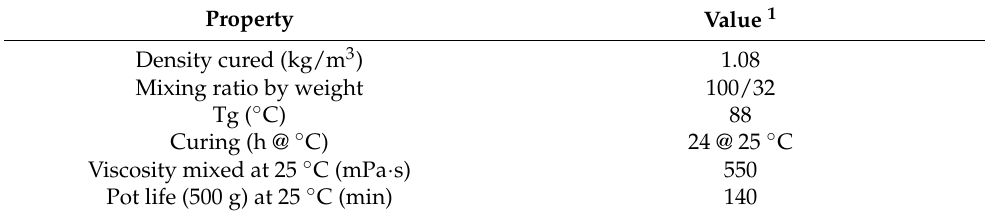
Table 1. Epoxy resin used in ZnO-epoxy composites. Property Value 1 Density cured (kg/m 3 ) 1.08 Mixing ratio by weight